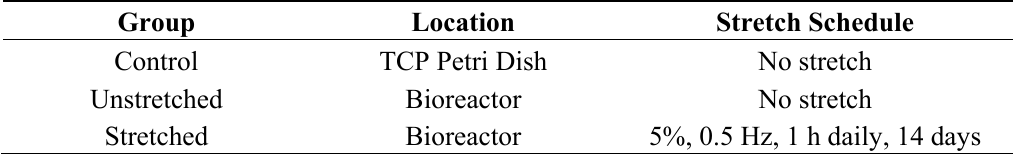
Table 1. Test and control group experimental